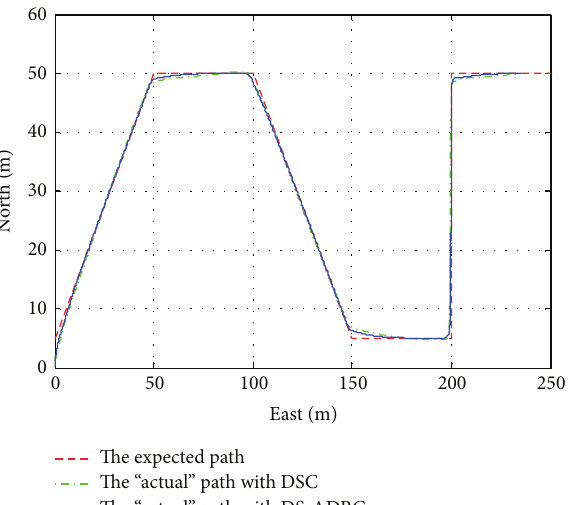
Figure 10: The output of force.